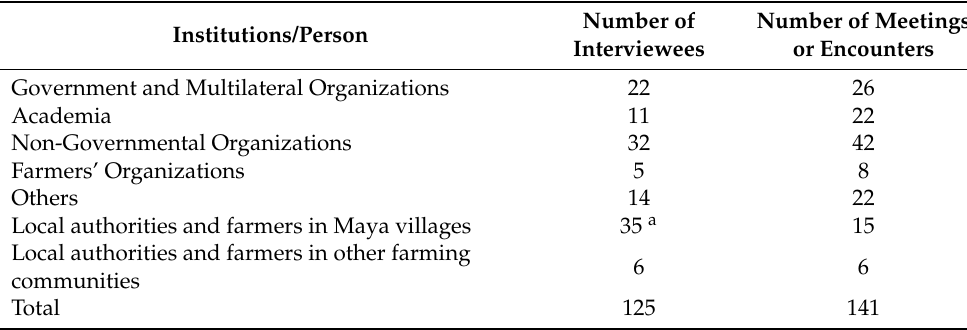
Table 1. Organizations and persons interviewed for agricultural survey in Belize (see detailed list of interviewees in Table S1). a Three community meetings are excluded from this figure.